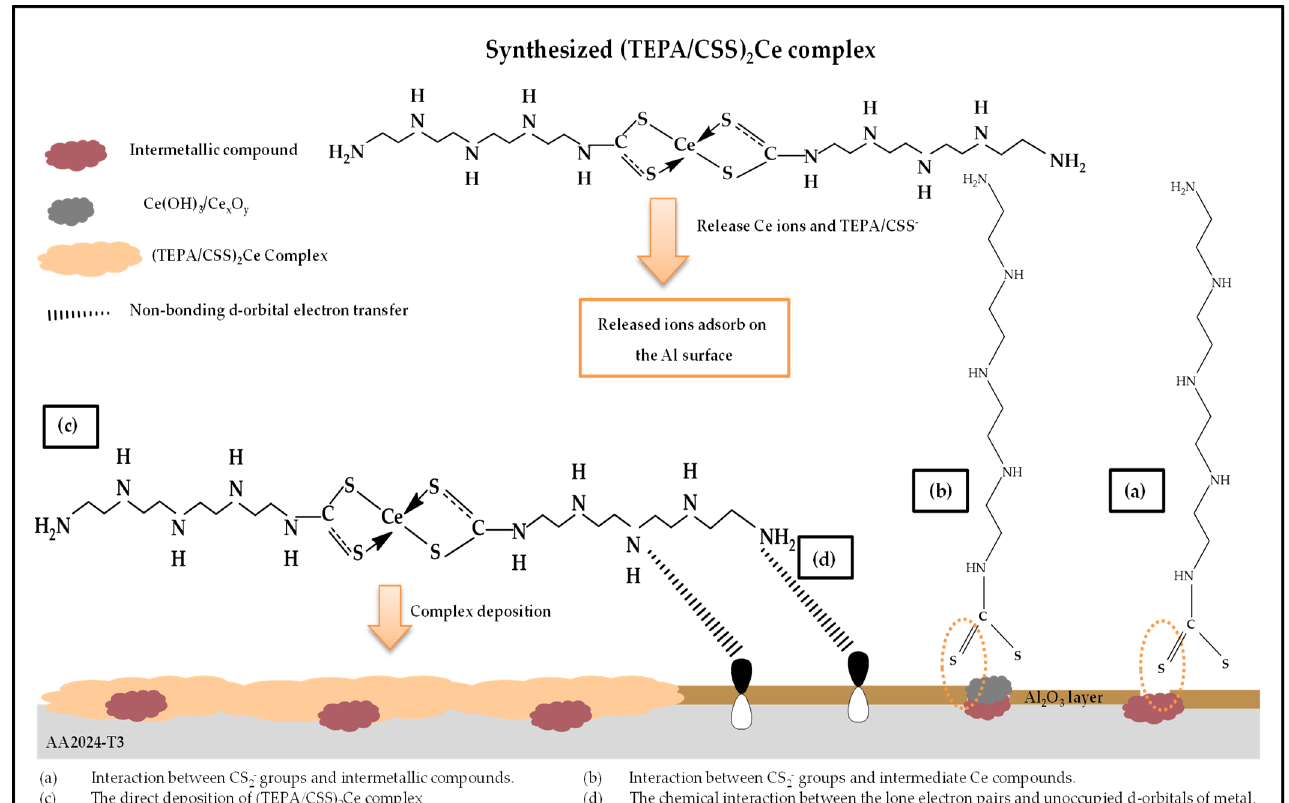
Figure 11. The corrosion protection mechanism of (TEPA/CSS) 2 Ce complex molecules on the AA 2024-T3 surface.